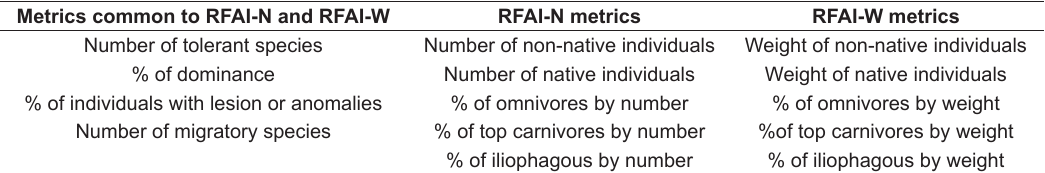
Figure 4. Steps (1 to 7) for fish-multimetric index construction. Table 1. Selected metrics for RFAI-N and RFAI-W for the Tietê cascade reservoir system (see Petesse et al., 2014 for